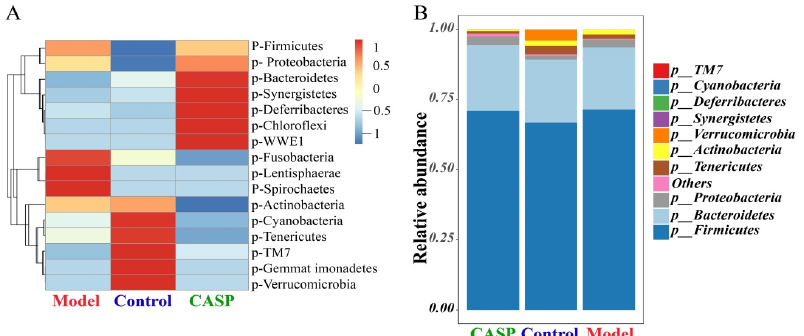
Figure 5. Relative abundance of floras at phylum level of chicken cecal contents in each group. Note: ( A ) Cluster analysis diagram of relative abundance; ( B ) Relative abundance diagram of floras dis ‐ tribution.